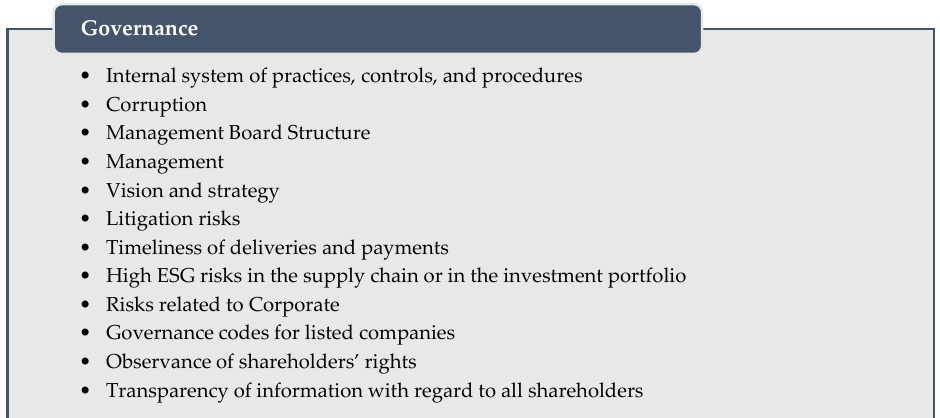
Figure 1. Selected factors used for ESG ratings and the assessment of non-financial economic operators, financial institutions, insurance companies and other organisations. Source: own work based on references: Idasiak, M. (2019), p. 84 [13]; Szczanowicz and Saniuk (2016), p. 104 [15]; Henisz et al. (2019), p. 1 [16]; Sikacz and Wolczek (2017), pp. 173–174 [17]; Ahmed et al. (2018), pp. 73–74 [18].